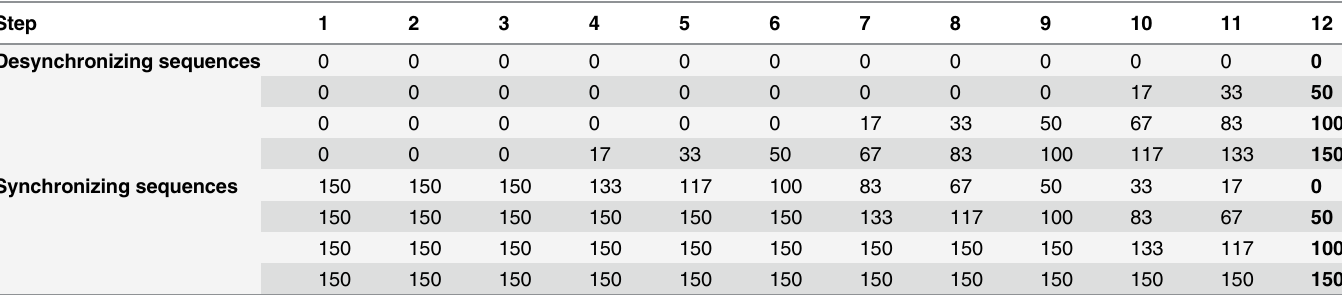
Table 1. Sequences of AV intervals in Experiment 1 and Experiment 3: Synchronizing and Desynchronizing conditions. Step Desynchronizing sequences